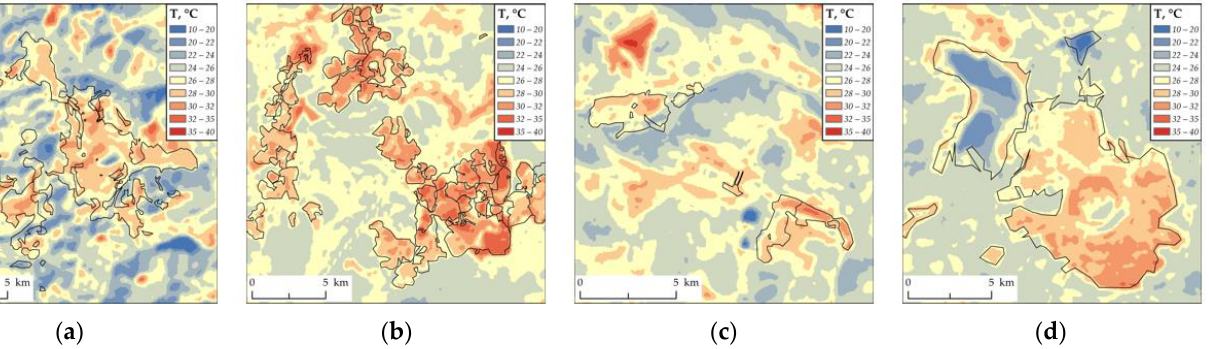
Figure 2. Temperature field for technogenic plots of ( a ) NMP (Magadan Region), ( b ) VMP (Irkutsk Region), ( c ) KMP (Republic of Sakha (Yakutia)), and ( d ) OMP (Krasnoyarsk Region).